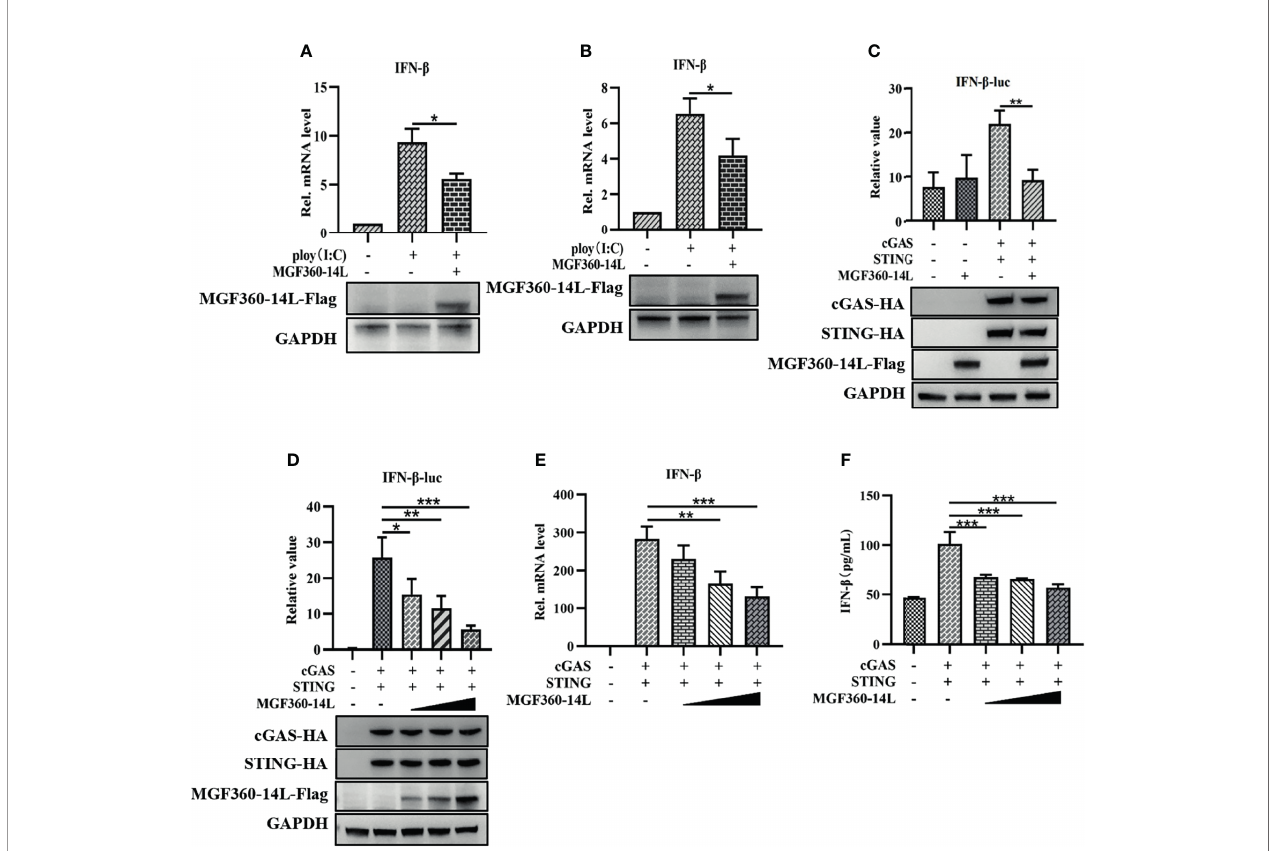
FIGURE 1 | MGF360-14L inhibited IFN- b mRNA production and IFN- b promoter activity. PK-15 (A) and HEK293T (B) cells were transfected with MGF360-14L plasmids and 5 m g/mL of poly(I:C) for 24 h and then harvested for qRT-PCR assay to determine IFN- b mRNA levels. MGF360-14L inhibited cGAS/STING-mediated activation of IFN- b (C) , and the inhibitory effect was dose-dependent (D) . HEK293T cells were co-transfected with IFN- b -luc (20 ng), pRL-TK (2 ng), cGAS-HA (10 ng), STING-HA (40 ng), or the pcDNA3.1-HA empty vector (50 ng) and MGF360-14L-Flag (0 ng, 50 ng, 100 ng, 200 ng). Luciferase activity was detected at 24 h post-transfection. Expression of cGAS-HA, STING-HA, and MGF360-14L-Flag was analyzed by western blotting. (E, F) MGF360-14L inhibited cGAS/STING- mediated mRNA and protein levels of IFN- b . HEK293T cells were co-transfected with cGAS-HA (100 ng), STING-HA (100 ng), or the pcDNA3.1-HA empty vector (100 ng) and MGF360-14L-Flag (0 ng, 50 ng, 100 ng, 200 ng). The mRNA level of interferon- b in cell lysate was detected by qPCR, and the protein expression level of interferon- b in supernatant was detected by ELISA. Data shown are the mean ± SEM; *p < 0.001, **p < 0.001, ***p < 0.001. Representative results are from at least three independent